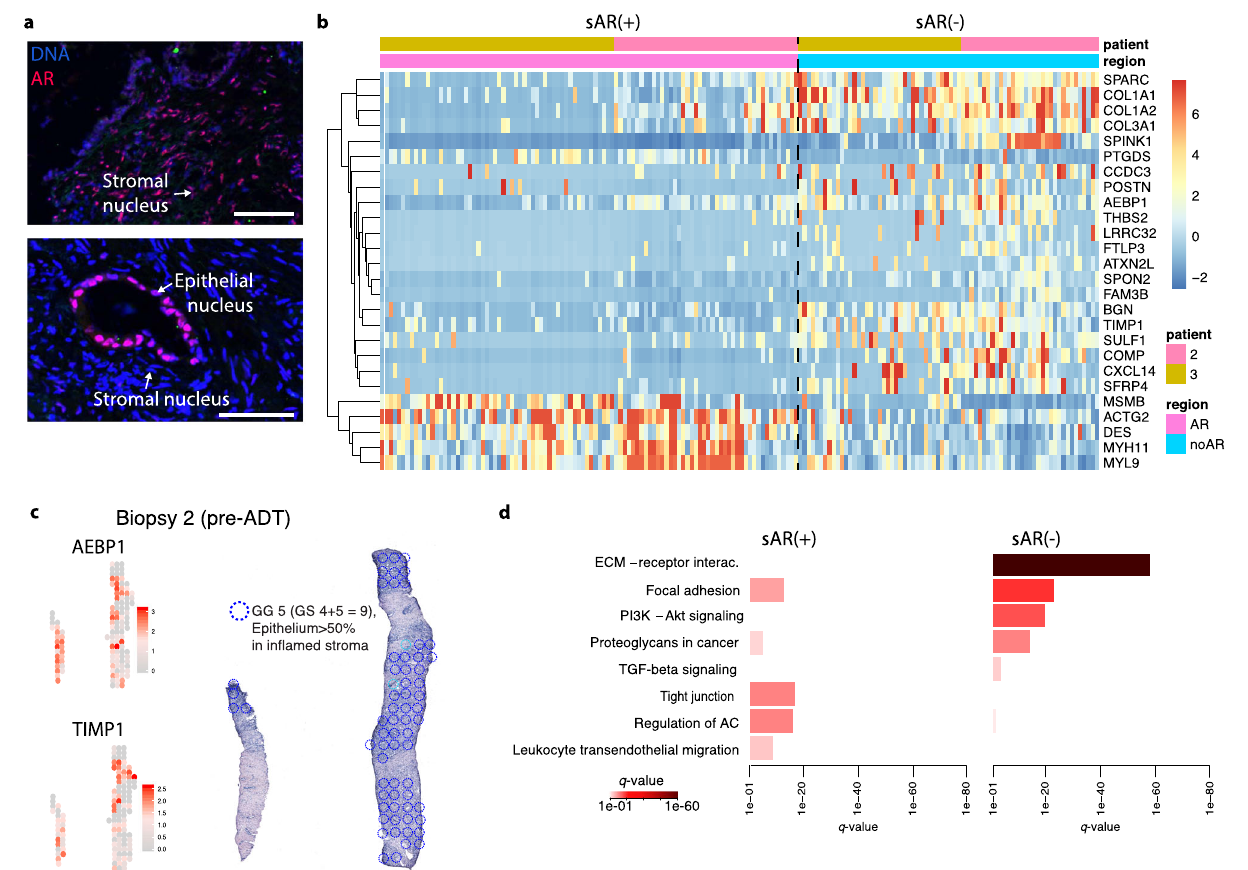
Fig. 5| AR(+) stromaversusAR( − ) stroma inbiopsiespre-ADT. a Representative images of sAR(+) (top) and sAR(-) (bottom), in patient 2. Note the AR(+) luminal epithelial cells of the gland (bottom). Scale bars 50 µ m. b Heatmap of the 26 DEGs (two-sided Wilcoxon rank-sum test adjusted for multiple comparisons, q -value<0.05, log FC>0.5)in the stroma with and without nuclearAR across spots inpatient2and3,respectively.SourcedataisprovidedasSourceData fi le. c AEBP1 and TIMP1 expression in a tissue section from patient 2 (pre-ADT, biopsy 2, left).